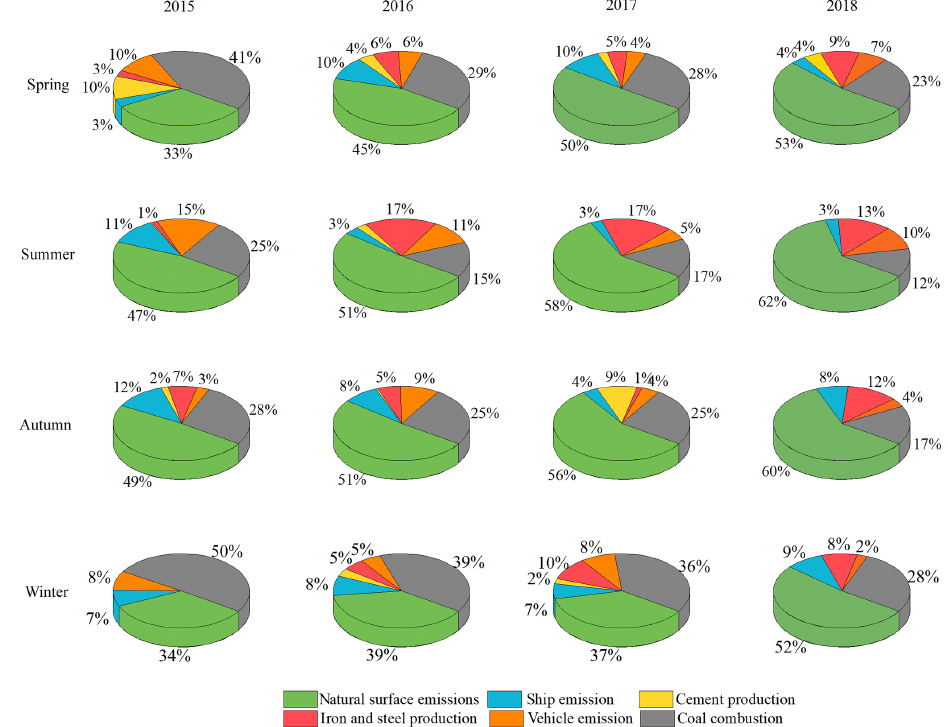
Figure 6. Contributions of natural surface emissions and anthropogenic sources to atmospheric GEM in the four seasons during 2015–2018.